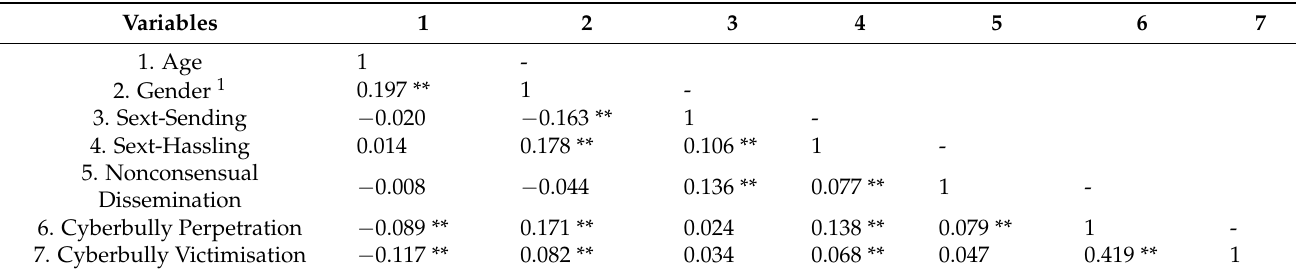
Table 2. Correlations for Study Variables.